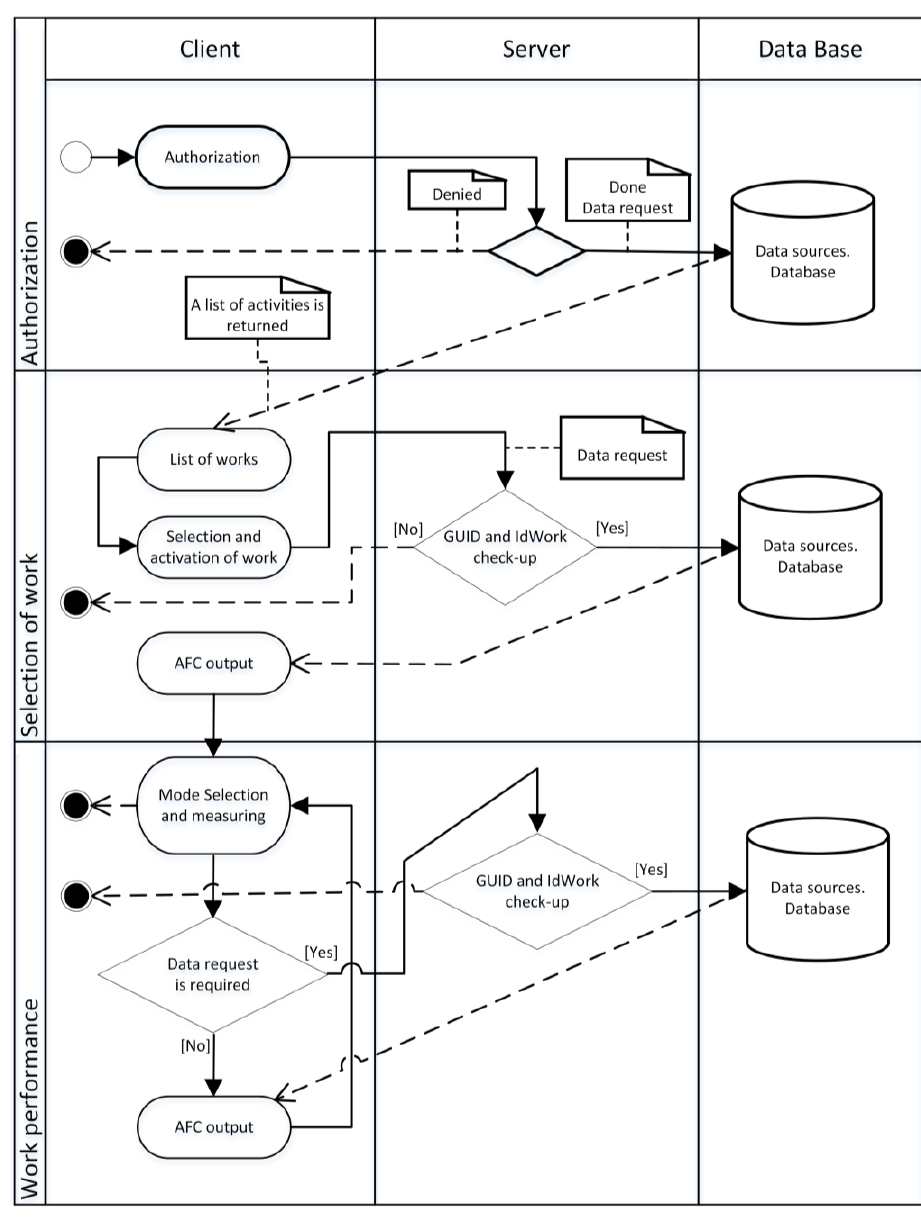
Fig. 3. Client-server interaction